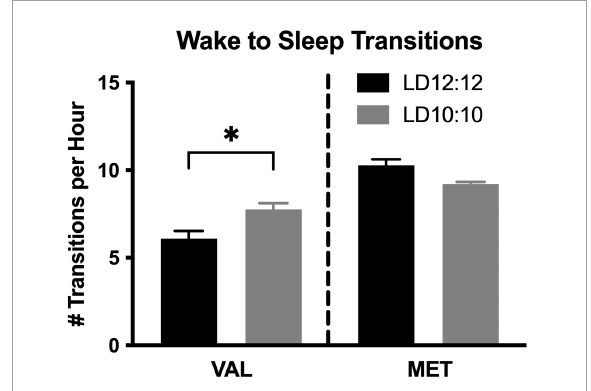
FIGURE2 Wake to sleep transitions are differentially impacted by ECD in Val and Met mice. Graphs show changes in wake to sleep transitions. LD10:10 ECD (20 days) resulted in an increase in the number of transitions from wake to sleep in the Val mice (black bar), but no difference was found in the Met mice (gray bar). One-Way ANOVA; ∗ p <